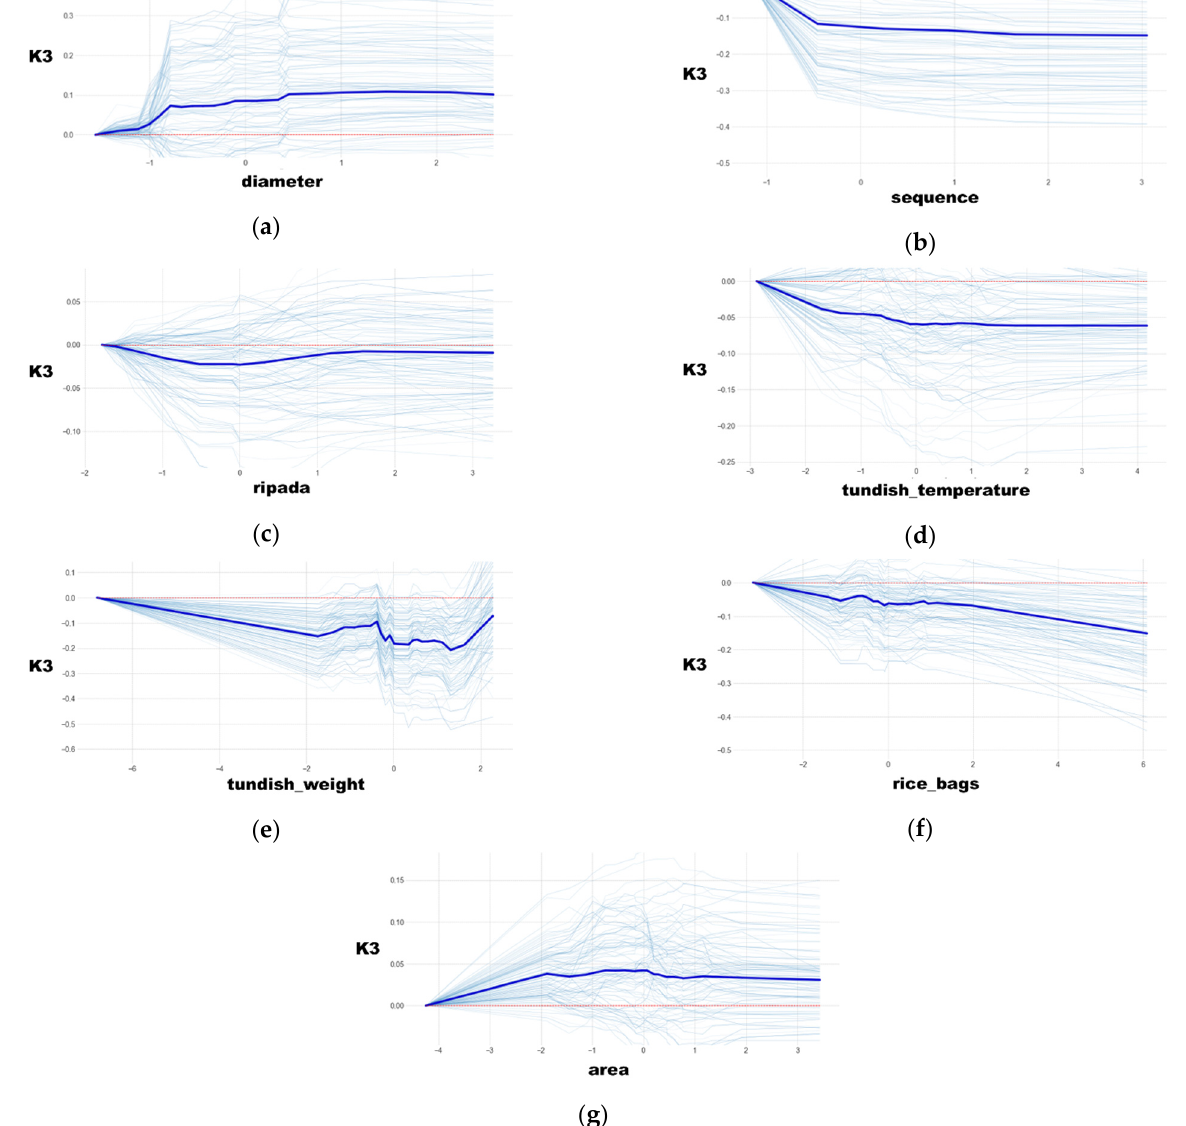
Figure 6. PDPs obtained through the RF model on the seven most relevant features identified by means of the PI algorithm: ( a ) diameter, ( b ) sequence, ( c ) ripada, ( d ) tundish temperature, ( e ) tundish weight, ( f ) rice bags and ( g ) area.